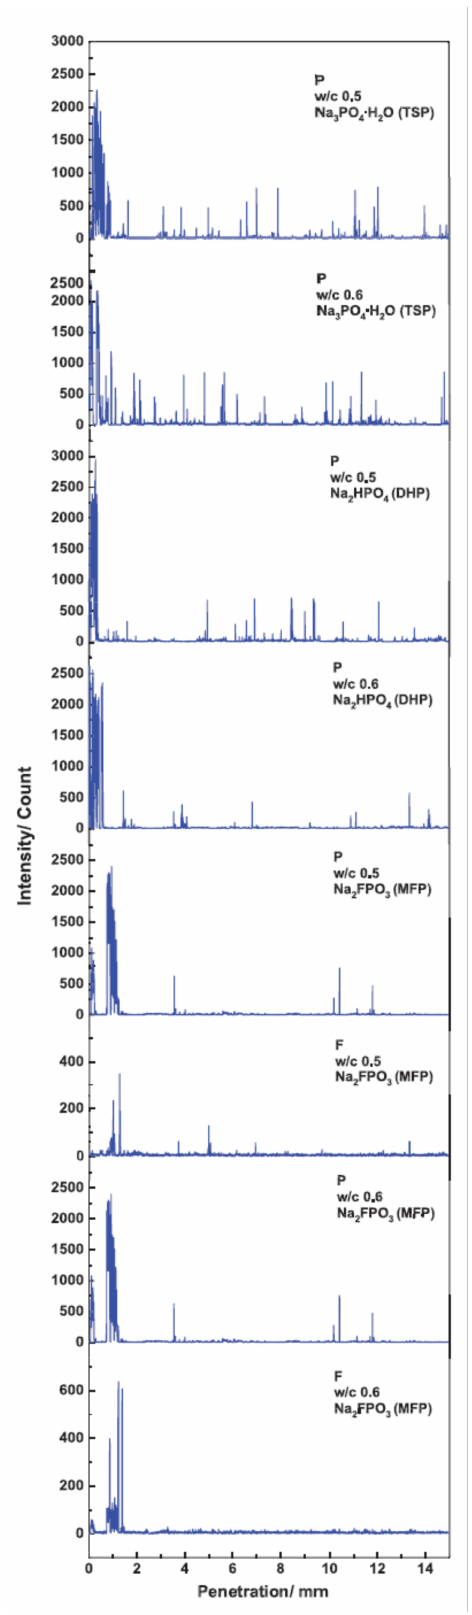
Figure 13. Electron probe micro-analysis (EPMA) of intensity versus penetration depth [44]. Repro- duced with permission from Criado, M. et al., Eur. J. Environ. Civ. Eng.; published by Taylor and Francis,